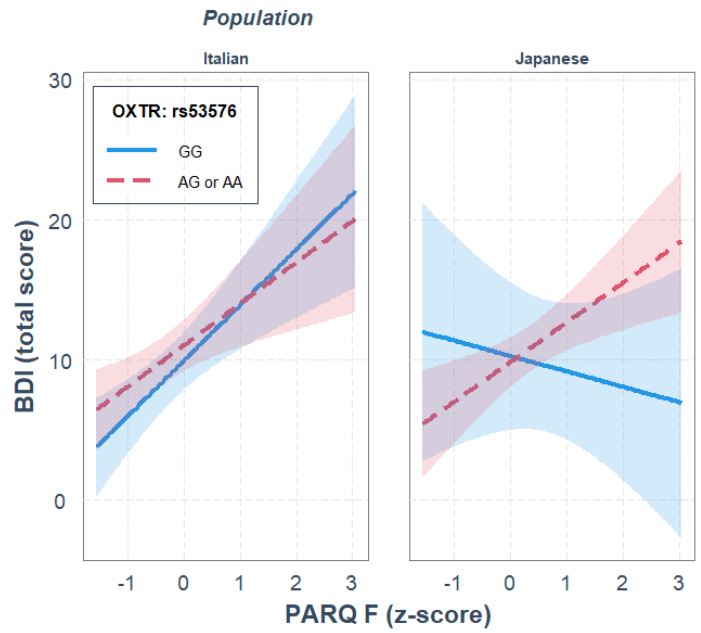
Figure 2. Single regression analyses predicting depression (BDI) from remembered paternal rejection as a function of OXTR rs53576 gene polymorphisms and population.